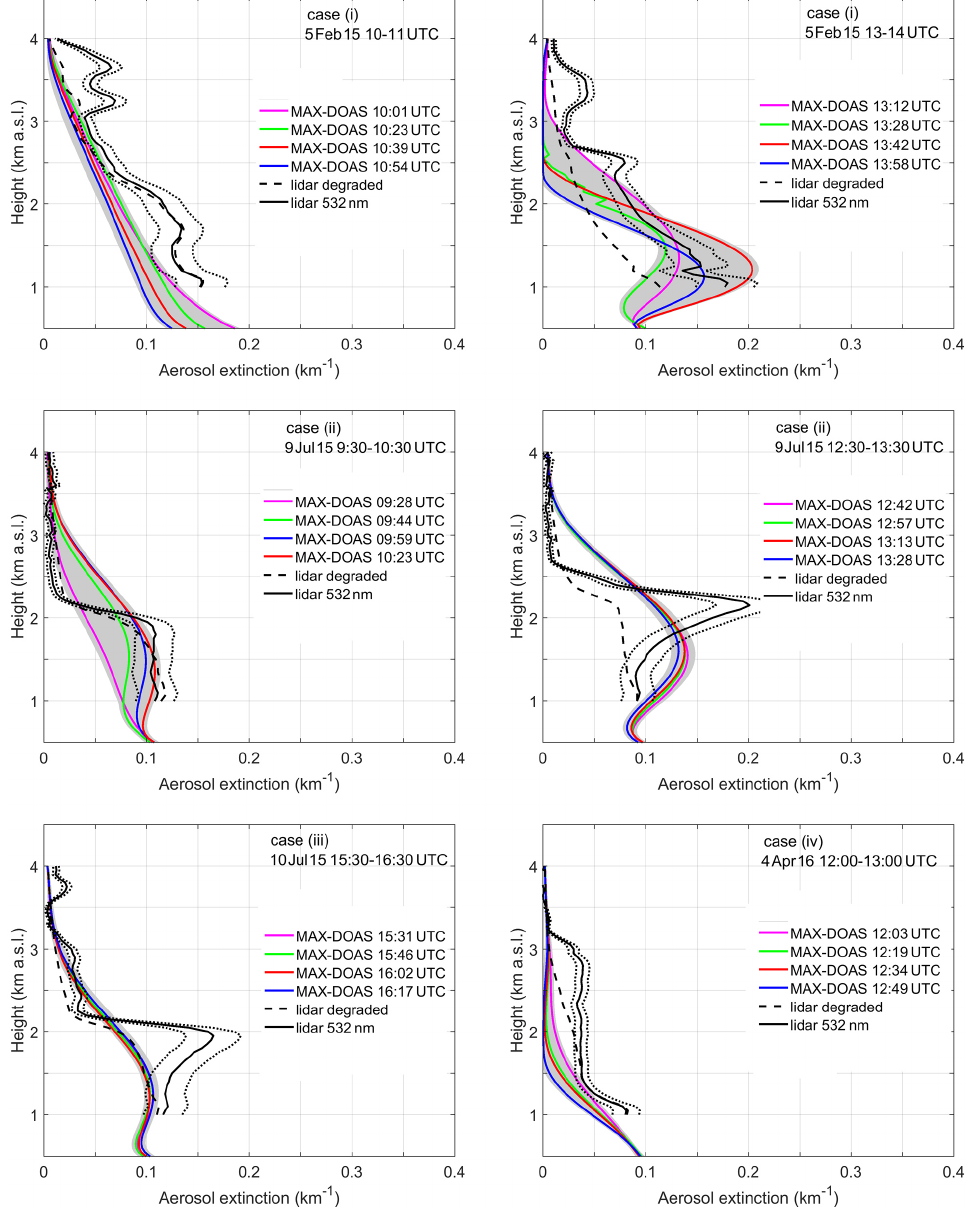
Figure 6. Comparison of retrieved MAX-DOAS aerosol extinction profiles at 477nm (multicoloured curves), lidar aerosol extinction coeffi- cient vertical profile at 532nm (black curve) and the corresponding degraded lidar profile (dashed black curve) for the selected case studies. The lidar profile used in each case is the average profile retrieved between the starting and the ending time of the MAX-DOAS retrievals, and the light dashed black curves are the lidar-derived aerosol extinction uncertainty obtained by the lidar assumption of 50 ± 20sr. The grey shaded area represents the corresponding MAX-DOAS